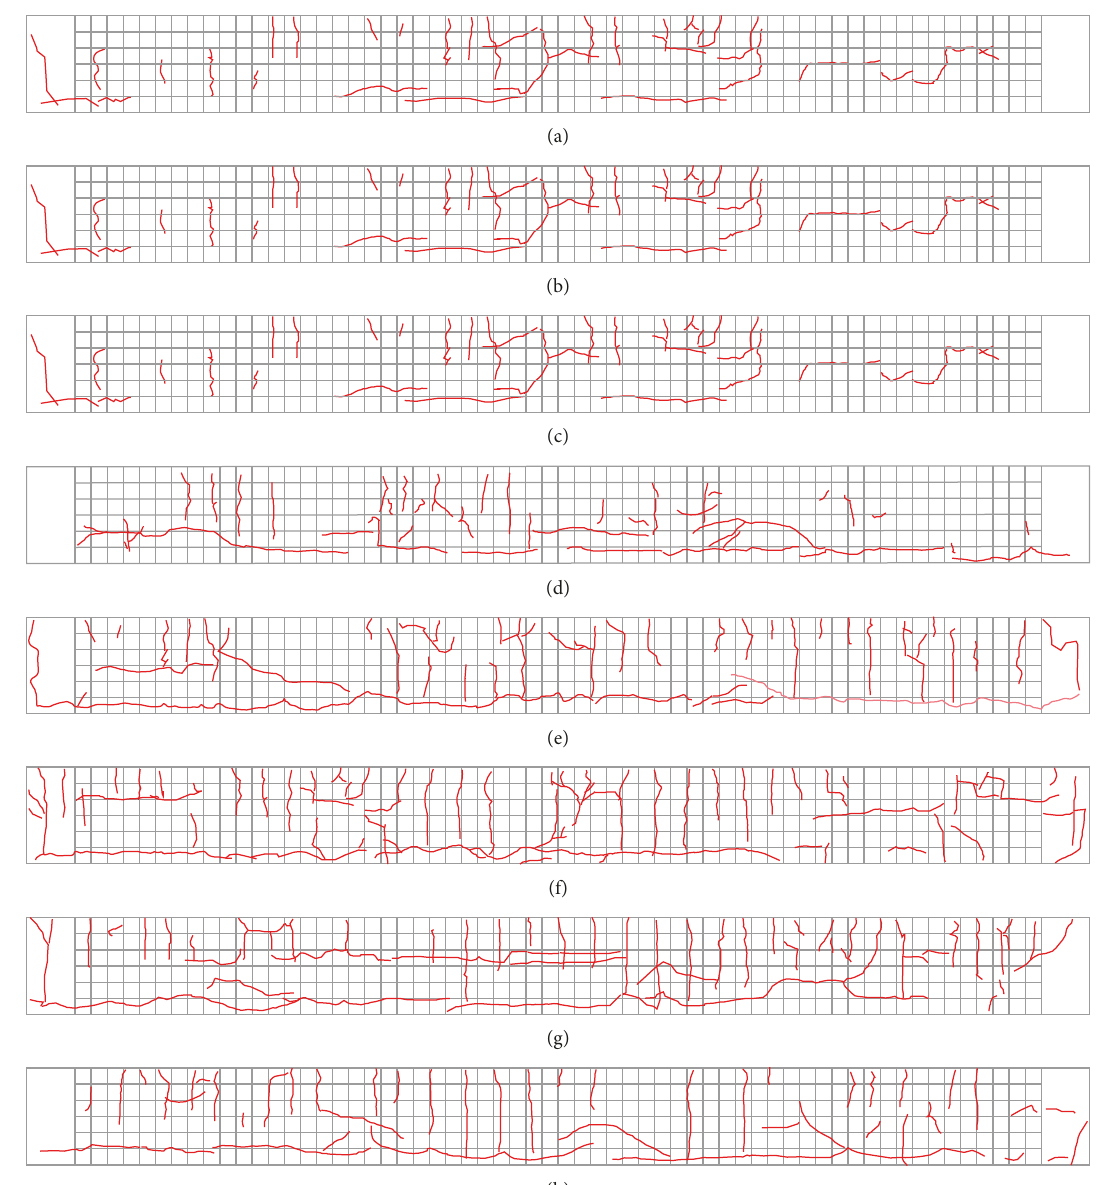
Figure 7: Corrosive cracks on the eight specimens after electricity application. (a) RCB-0, (b) RCB-33, (c) RCB-66, (d) RCB-100, (e) HRCB-0,